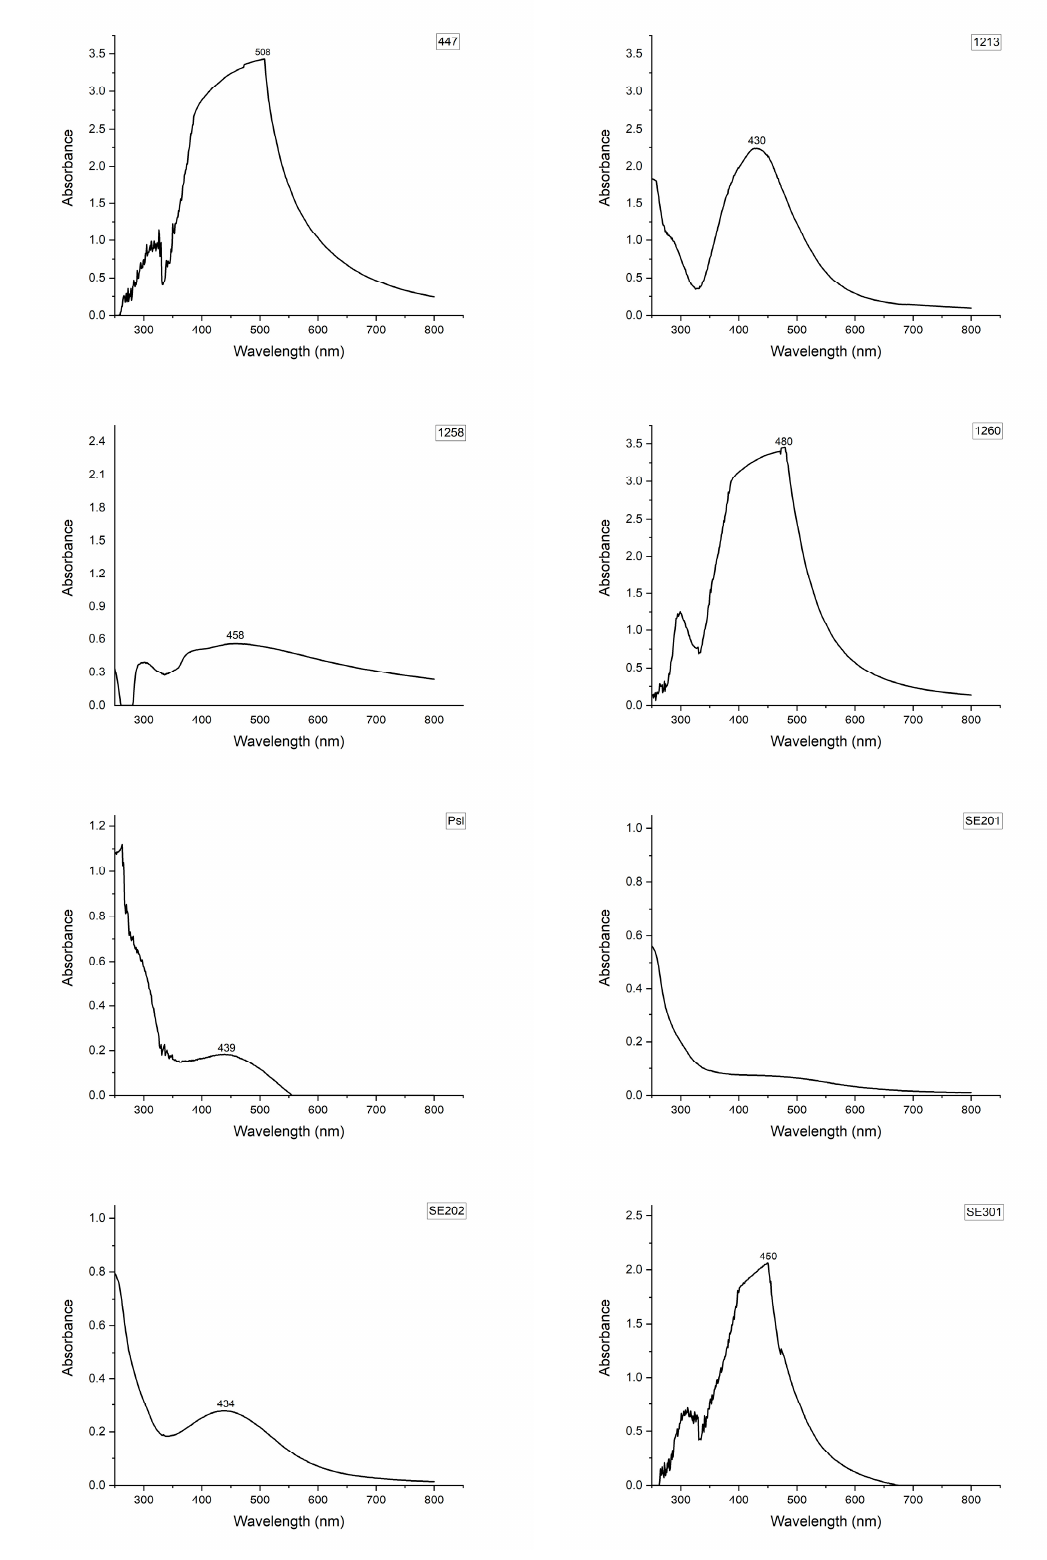
Figure 2. UV/visible absorption spectra of the synthesis reactions of silver nanoparticles with aqueous extracts of different entomopathogenic fungi. The used blank solution was the fungal extract